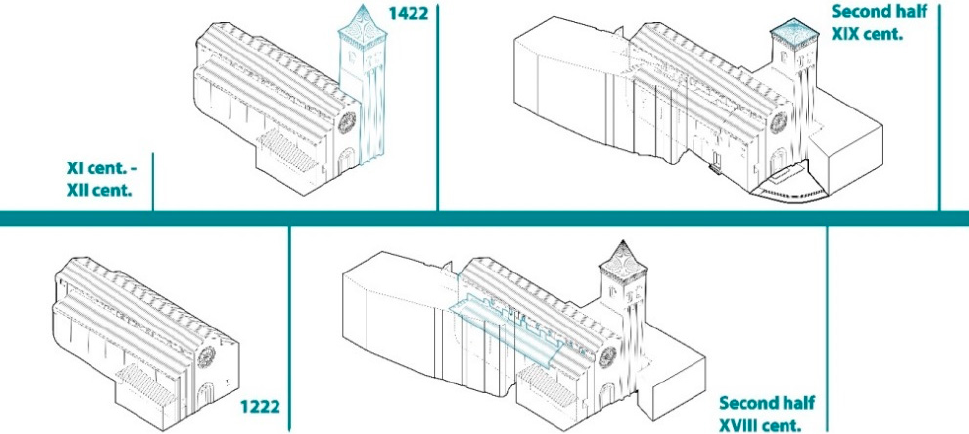
Figure 2. Timeline of the San Zenone Church, from the XI Century to the Second half of XIX Century.